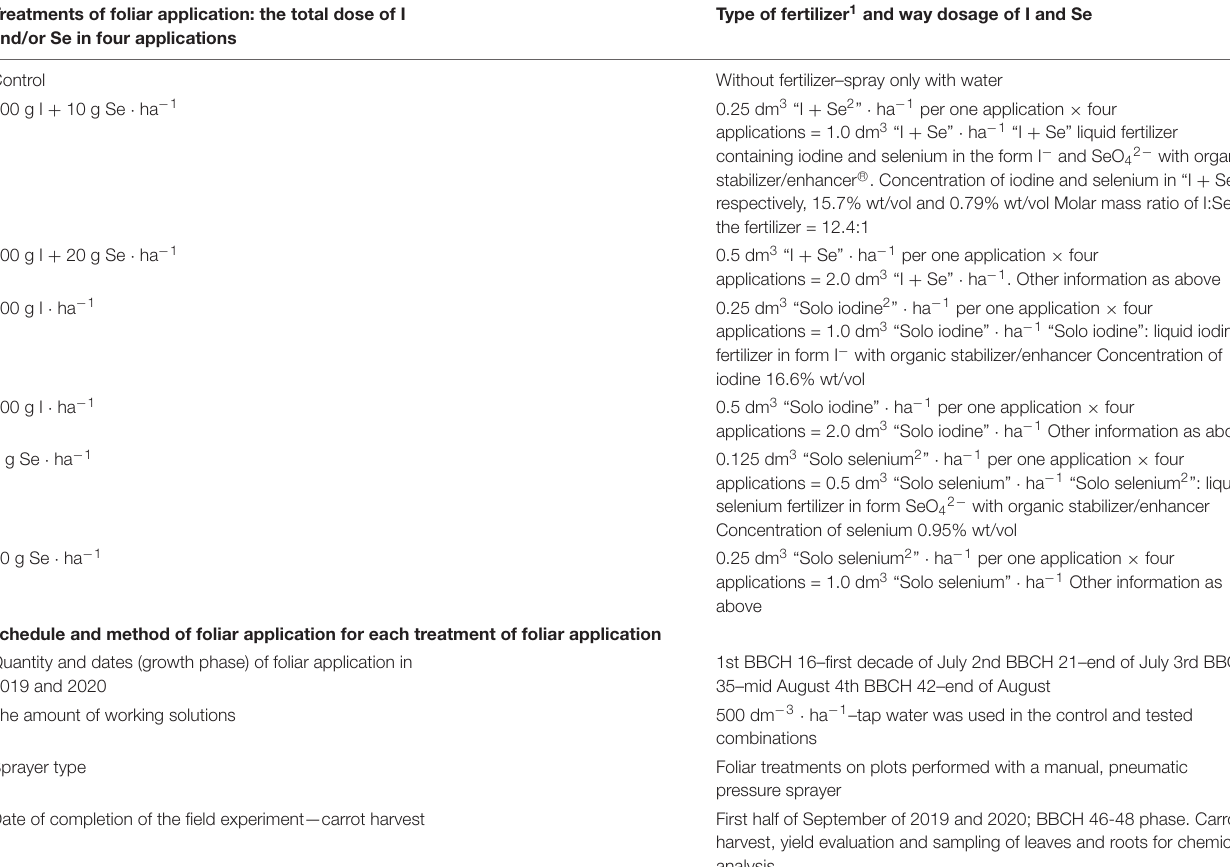
Type of fertilizer 1 and way dosage of I and Se